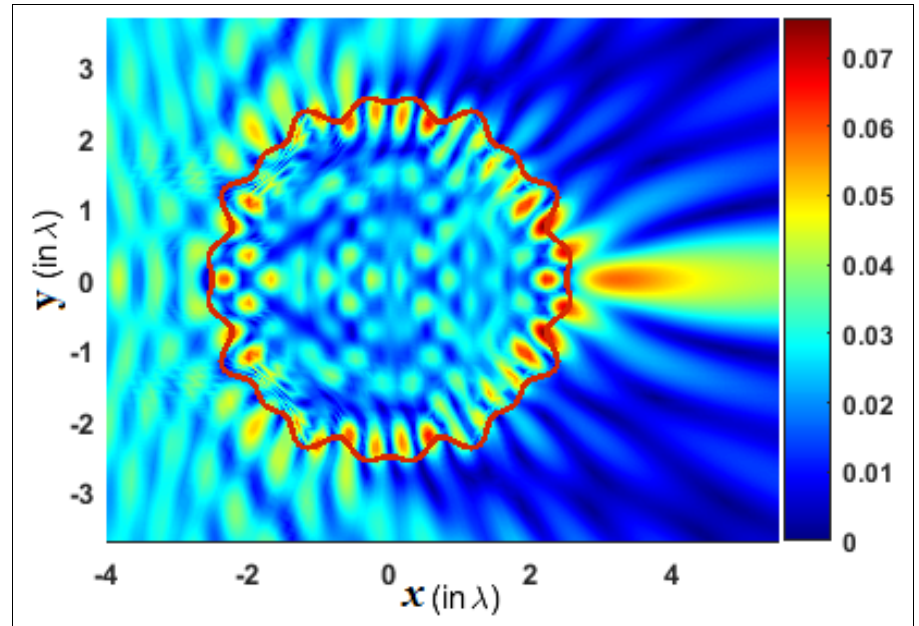
Figure 6. Illumination by a point-source placed at 9 λ , n = 1.452, ( m 1 , m 2 ) = (16,4), and β = 0.178. (The colormap denotes the total field magnitude).